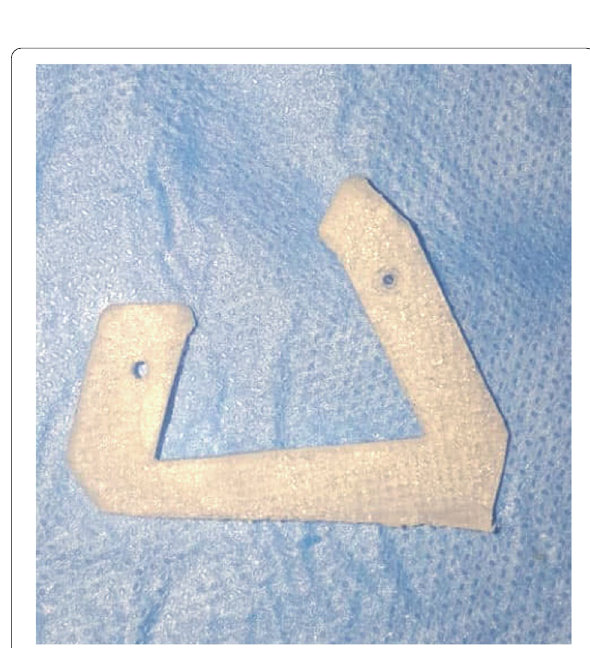
Fig. 3 Printed patient-specific osteotomy locating